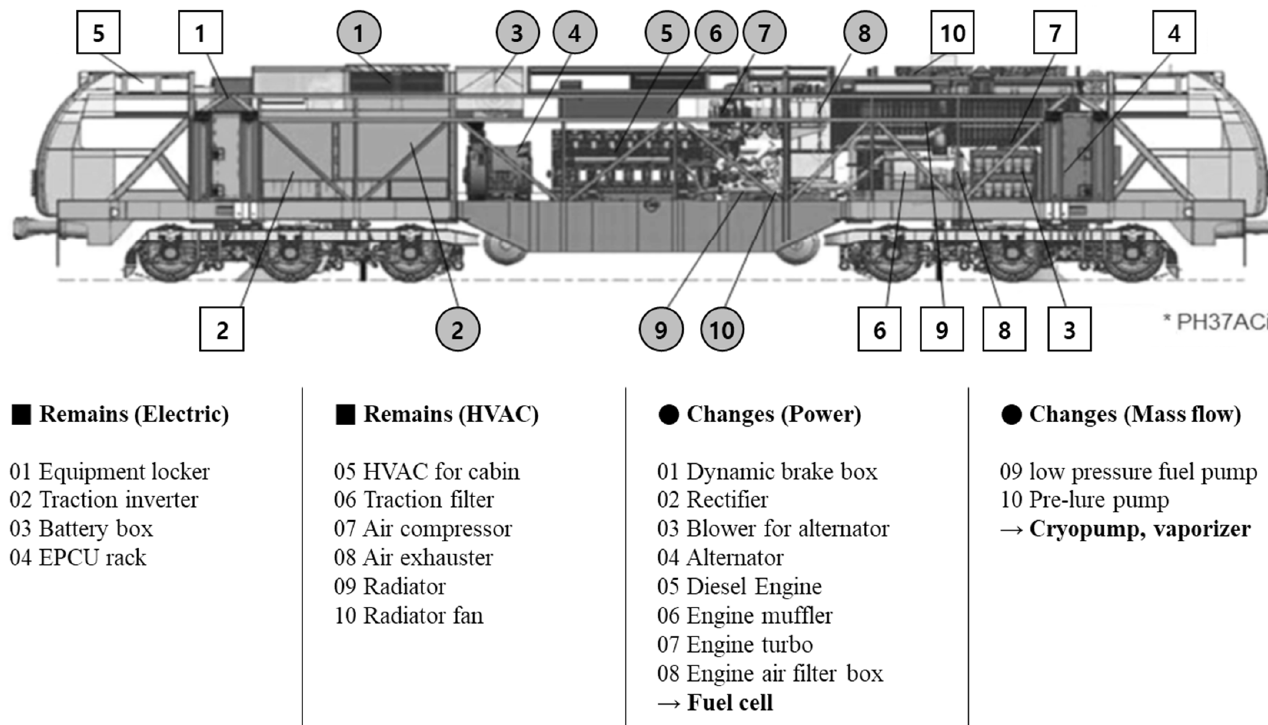
Figure 7. Sample of the configuration of the PH37ACi diesel–electric locomotive and components that will be changed.